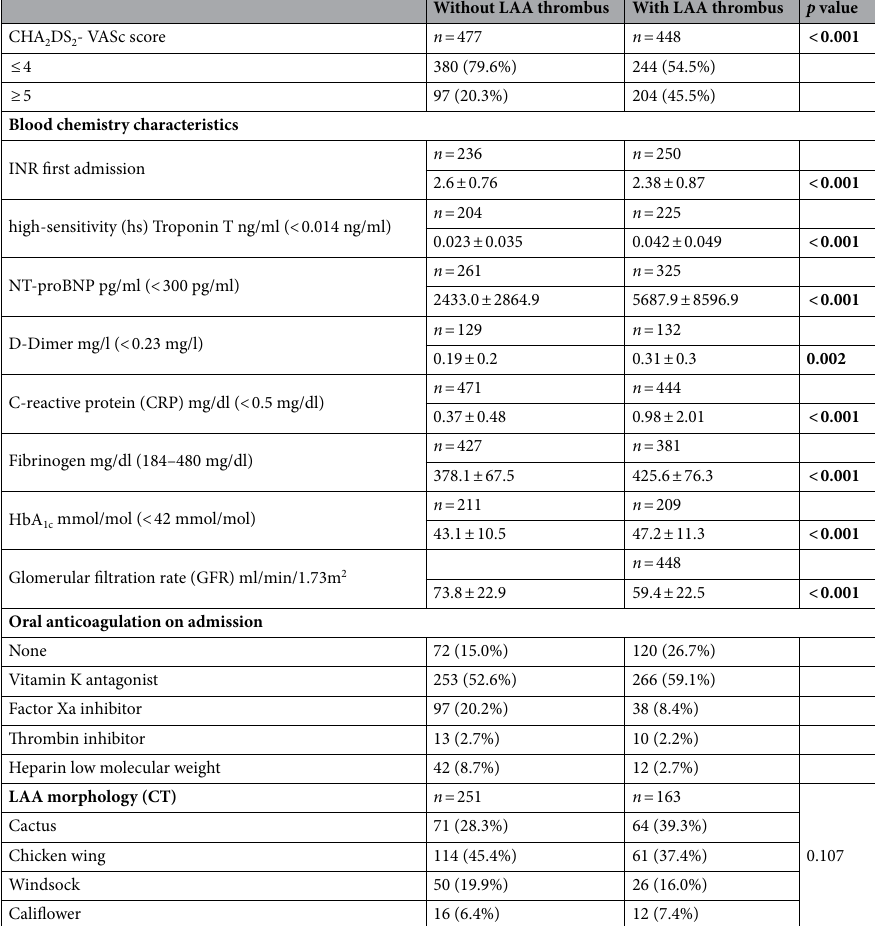
of non- chicken wing morphology in our study in the group with LAA thrombus (62.7% versus 54.6% in group without thrombus), the difference did not reach statistical significance ( p = 0.107). Correlation of biomarkers, markers of inflammation and renal function with LAA thrombus formation. Figure 2 a–d illustrates different concentration ranges of fibrinogen, CRP, troponin T and NT- proBNP in relation to percentages of patients with or without LAA thrombi. The percentage of patients with LAA thrombi rose with each level of these parameters (for further details see Fig. 2 a–d). More than half (64%) of patients with LAA thrombi had fibrinogen concentrations exceeding 421 mg/dl and 77.3% had CRP concentra- tions > 1 mg/dl (Fig. 2 a and b). 83% of patients with LAA thrombi showed NT-proBNP levels > 9000 pg/ml and 73.8% troponin T concentrations > 0.030 ng/ml (Fig. 2 c and d). An inverse relationship was found between glo- merular filtration rate (GFR) and patients with LAA thrombi. The lower the GFR, the higher the percentage of patients with LAA thrombi was. In 75.9% of patients with LAA thrombi, GFR was < 40 ml/min/1.73m 2 (Fig. 2e). Comparison of groups of patients that resolved versus did not resolve LAA thrombi. Baseline characteristics are shown in Table 2. Patients with persistent LAA thrombi were significantly older ( p < 0.001), had more strokes ( p = 0.012) and had significantly higher CHA 2 DS 2 -VASc scores ( p = 0.002). In the group with persistent LAA thrombus, prevalence of tricuspid valve regurgitation including reconstruction was higher ( p = 0.012), and the sizes of the right atrium were larger ( p < 0.01). In the group that dissolved the LAA thrombus, LAA flow velocities measured in the last TOE were signifi- cantly higher compared to those in the first TOE (32.7 ± 11.9 vs 20.3 ± 5.3, p < 0.001), whereas they did not change in the group that did not dissolve LAA thrombus (18.1 ± 4.9 cm/s vs.18,7 ± 4,8 cm/s, p = 0.836, Fig. 3). Blood chemistry revealed worse renal function, higher levels of troponin T and fibrinogen ( p < 0.001) and a less well controlled diabetes mellitus ( p = 0.028) in patients with persistent LAA thrombi. In both groups, INR